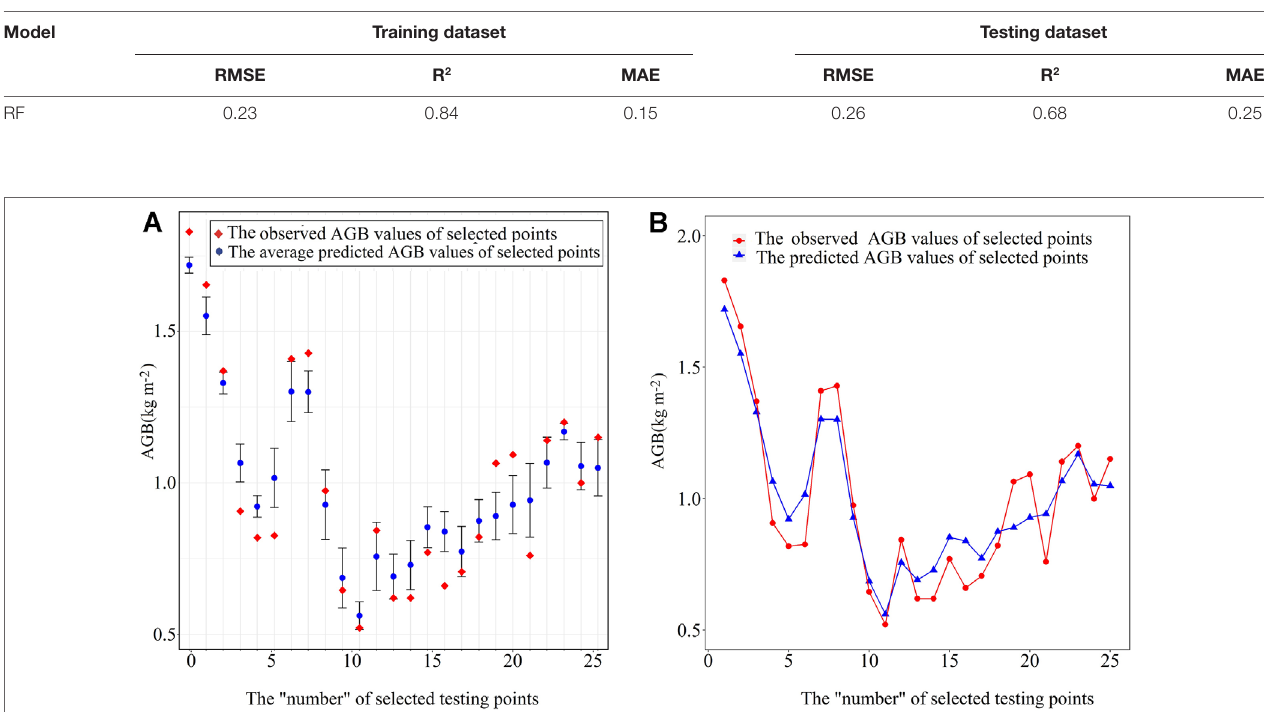
FIGURE 7 | Comparison of predicted with error bar in (A) and without error bar in (B) and actual values of AGB on RF Model validation sample set when N